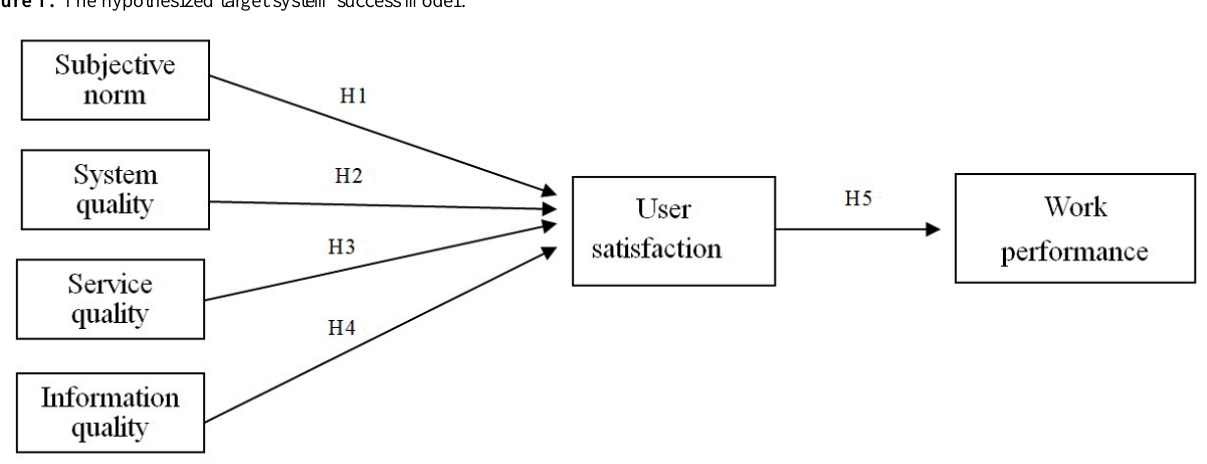
Figure 1. The hypothesized target system success